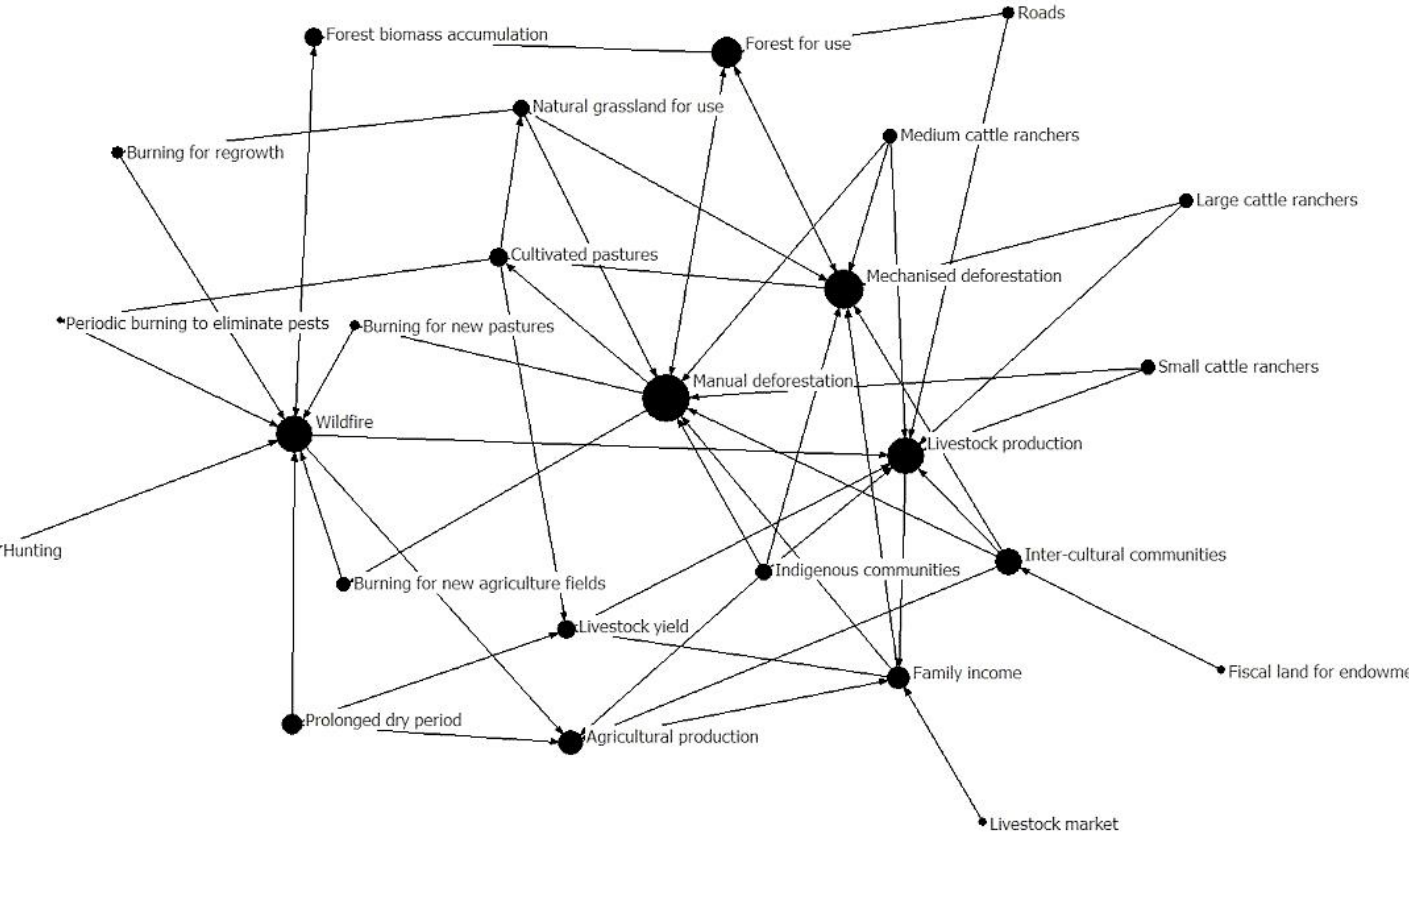
Fig. A6.3. Network showing the FCM developed in Concepción by the cattle ranchers. Variables with higher degree centrality are presented as larger nodes. Edge weights are not visualized to help